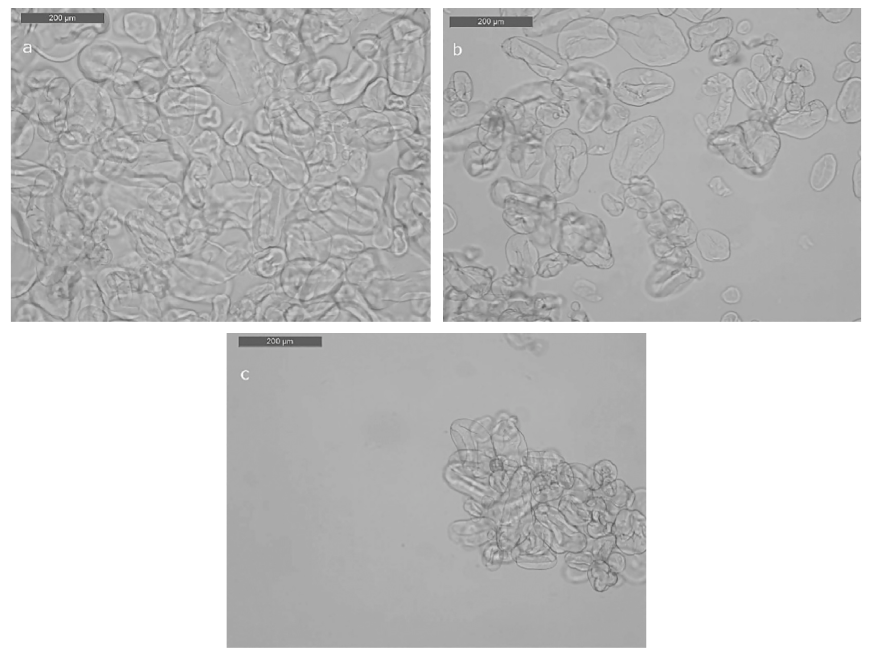
Figure 6: Morphology of CMS/CS hydrogel at ratios of: (a) 320, (b) 64, and (c) 50.